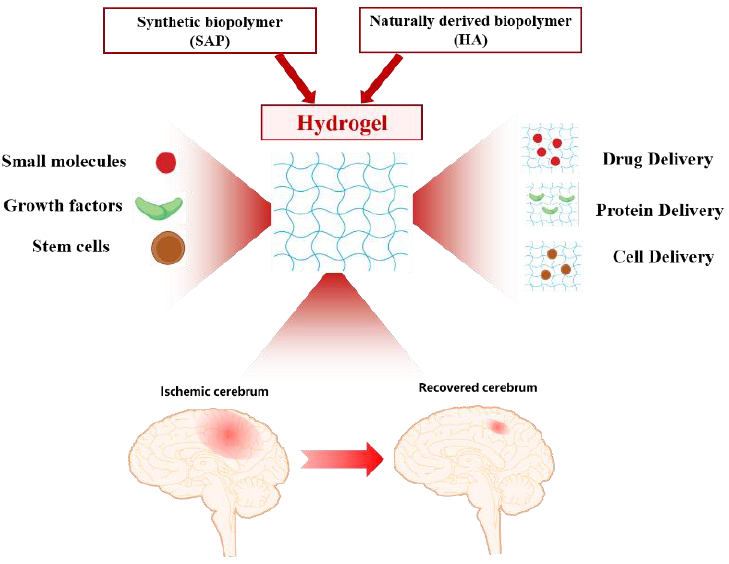
Figure 1. Schematic description of the hydrogel application in the treatment of ischemic strokes.